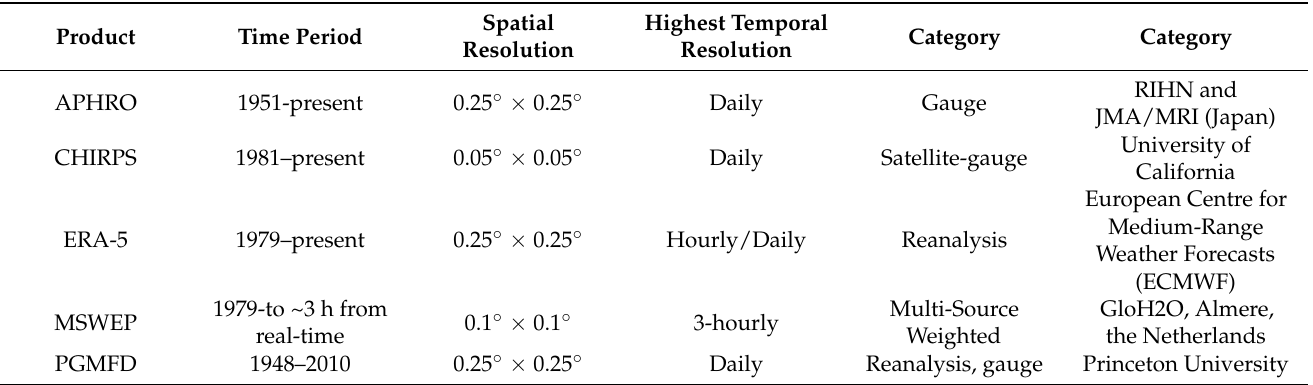
Table 2. General information of five GPPs assessed in this